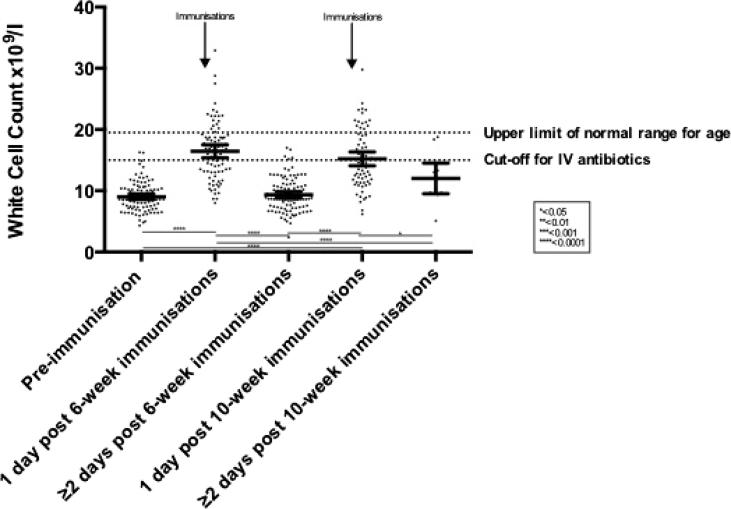
Total white cell counts by immunization status. Individual data points are represented by dots. Error bars display the 95% confidence interval.